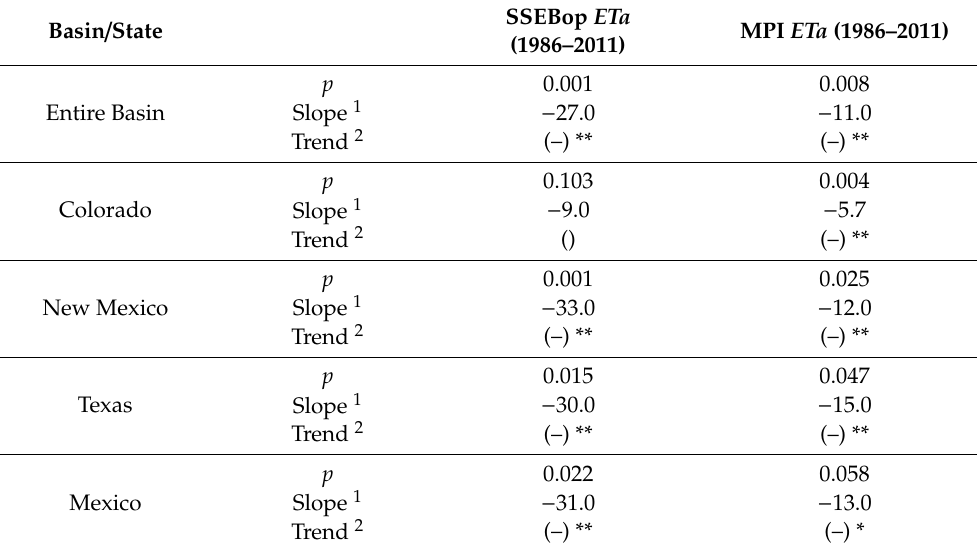
Table 5. Mann–Kendall trend analysis (June-August 1986–2011) of the spatially averaged ETa from SSEBop and from MPI for the entire basin and regions for all cropland and non-cropland